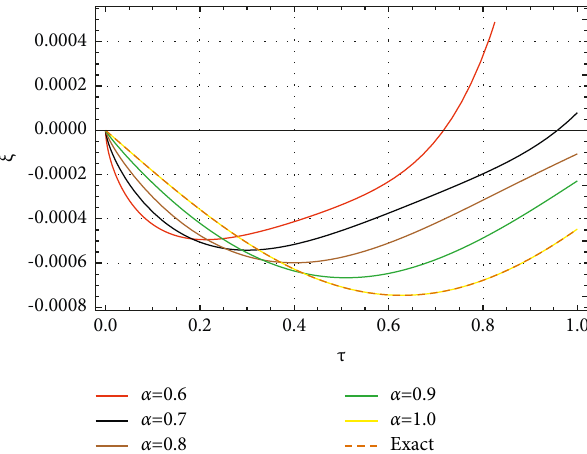
Figure 5: The approximate and exact solutions to the real part of Example 3.